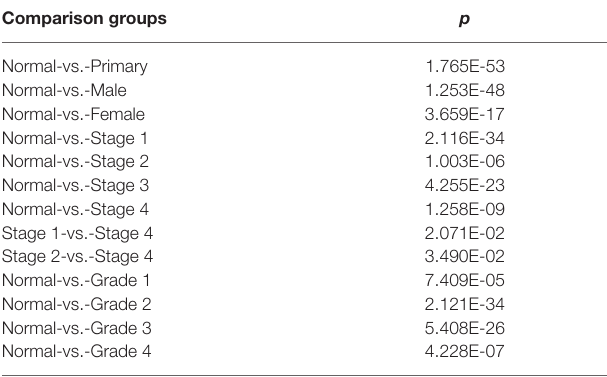
TABLE 3 | Association of PATJ protein and ccRCC pathological features. Comparison